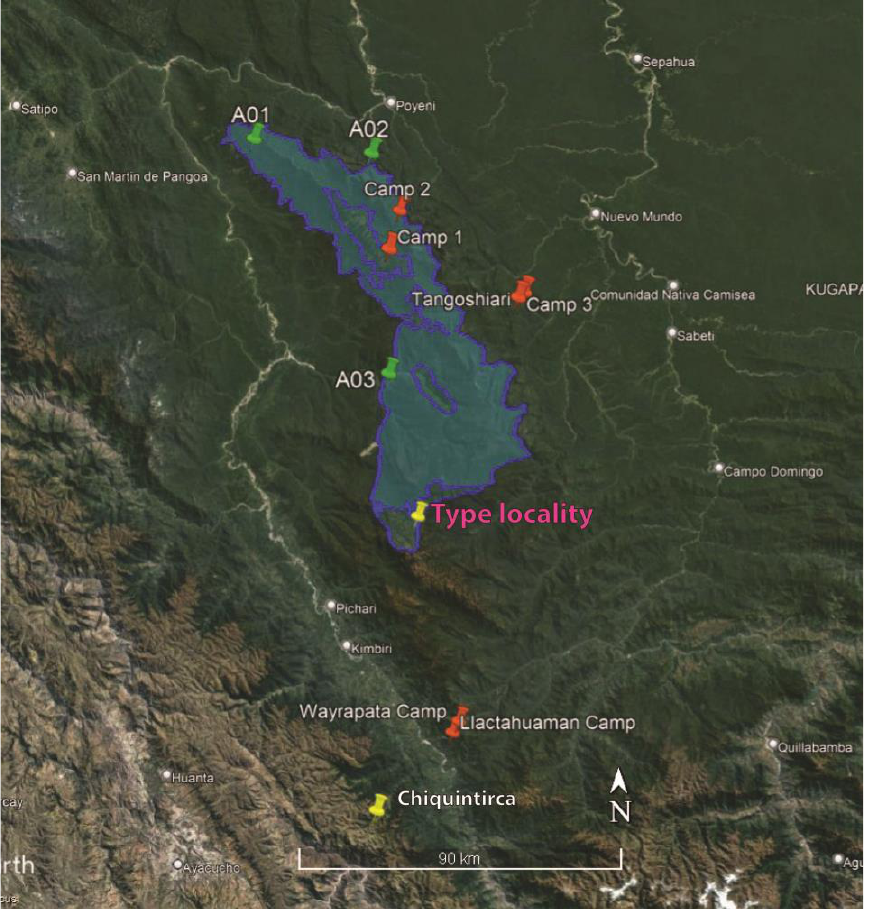
Figure 2. Google Earth image with the border of the Otishi National Park in blue. In orange are the six RAP collecting sites by Alonso et al. [3], in green are the three collecting sites by Barboza Sánchez [10], in yellow is the type locality of Proctoporus titans sp. nov. and the referred specimens from Chiquintirca.